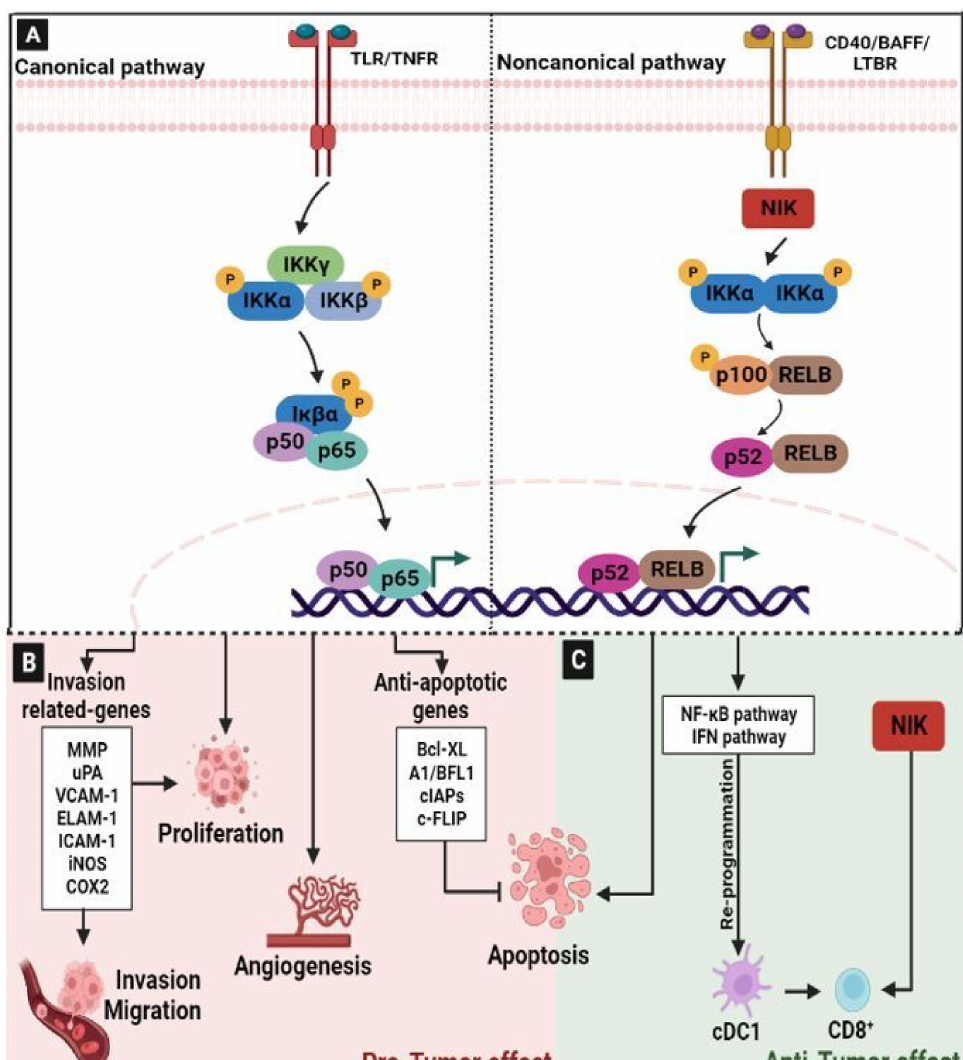
Figure 5. The NF- κ B signaling pathway in colorectal cancer. ( A ) Schematic representation of activated NF- κ B pathway: The canonical pathway is induced by TLR and TNFR. Activation of this cascade leads to the degradation of inhibitory protein I κ B through its phosphorylation by a trimeric complex composed of IKK α and IKK β , and IKK γ . The IKK complex phosphorylates p65/p50-bound I κ B then translocates into the nucleus. The non-canonical pathway is dependent on the activation of the p100/ RelB complex by BAFFR, CD40, and LTBR. This cascade induces the phosphorylation of NIK, which subsequently phosphorylates IKK α . Then, p52-RelB heterodimer is activated and translocates to the nucleus. ( B ) NF- κ B signaling plays a significant role in the tumorigenesis process via the regulation of downstream NF- κ B gene products linked to cell growth, inflammation, metastasis, angiogenesis, and the inhibition of apoptosis. It up-regulates the expression of invasion related-genes (MMP, uPA, VCAM-1, ELAM-1, ICAM-1, iNOS, and COX2) and anti-apoptotic genes (Bcl-KL, A1/BFL1, cIAPs, and cFLIP). ( C ) NF- κ B and IFN pathways also play an important role in the re-programmation of conventional dendritic cells into cDC1, leading to effective recruitment and the activation of CD8+ T cells. The non-canonical pathway of NF- κ B through NIK plays an anti-tumor role by increasing glycolytic metabolism and the effector functions of CD8+ T cells. Abbreviations: TLR: Toll-like receptors, TNFR: Tumor necrosis factor receptor, IKK: IkappaB kinase, I κβα : Nuclear factor-kappa B inhibitor alpha, CD40: Cluster of differentiation 40, BAFF: B-cell activating factor, LTBR: Lymphotoxin beta receptor, NIK: NF- κ B-inducing kinase, MMP: Matrix metalloproteinasec, uPA: